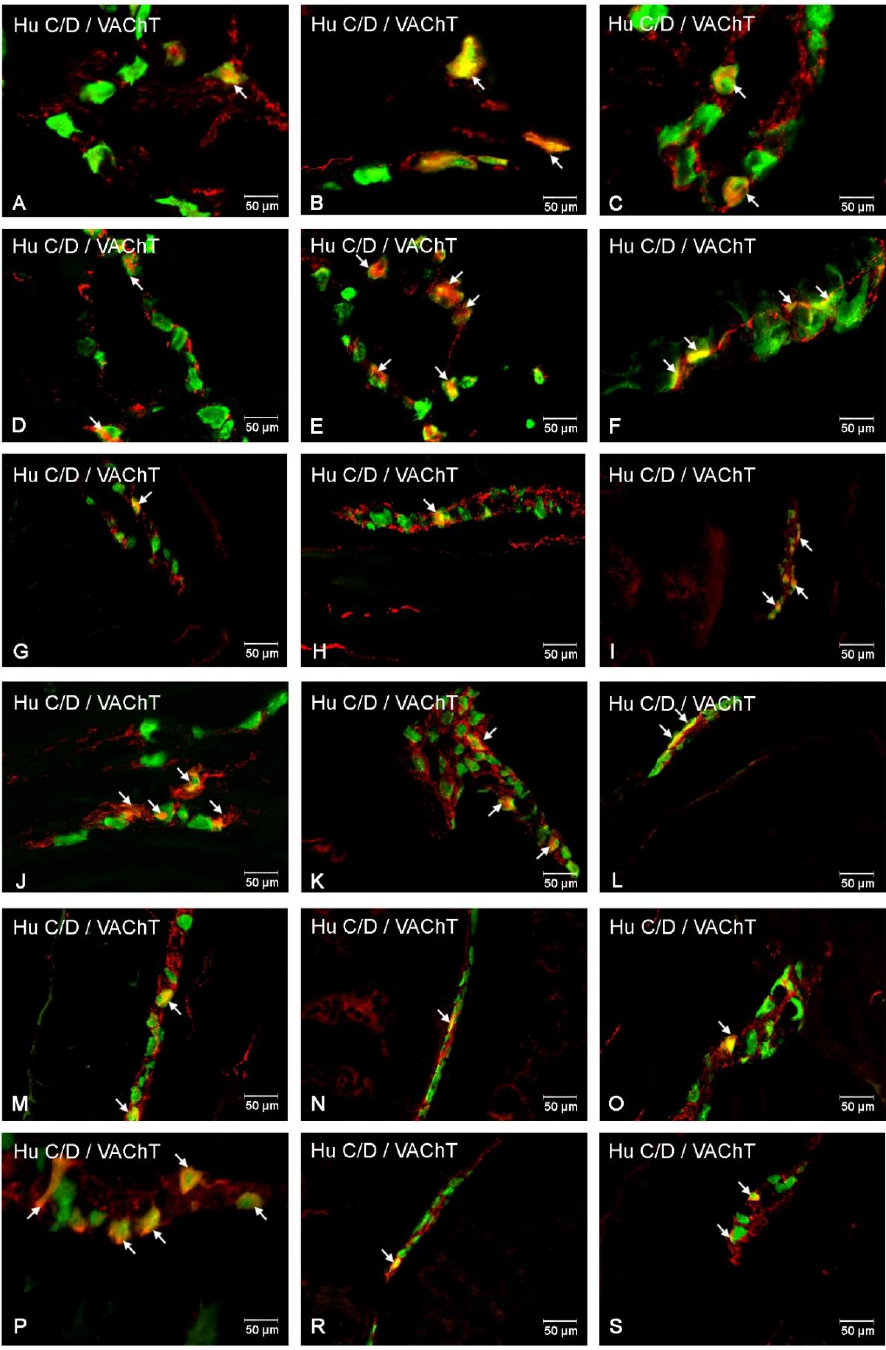
Figure 10. Immunofluorescent staining presenting VAChT immunoreactivity in cell bodies in the particular intramural plexuses in the small intestine in both control and experimental groups. All photographs have been created by the digital superimposition of two color channels; Hu C/D-positive—used here as a pan-neuronal marker (green), and VAChT-positive (red). The arrow shows perikaryon containing both examined substances. Myenteric plexus of the duodenum ( A,D ), jejunum ( B,E ), and ileum ( C,F ) under physiological condition ( A–C ) and after streptozotocin administration ( D–F ). Outer submucosal plexus of the duodenum ( G,J ), jejunum ( H,K ), and ileum ( I,L ) under physiological condition ( G-I ) and after streptozotocin administration ( J–L ). Inner submucosal plexus of the duodenum ( M,P ), jejunum ( N,R ), and ileum ( O,S ) under physiological condition ( M–O ) and after streptozotocin administration ( P–S